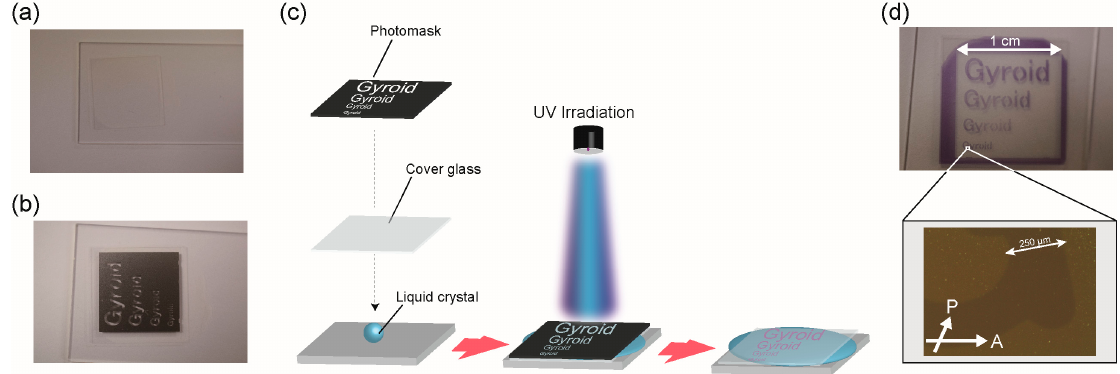
Figure 4. ( a ) Cub bi (V 2+ ) sample sandwiched between a glass plate and a cover glass; ( b ) A picture of the patterned photomask; ( c ) Experimental procedure for UV-pattering experiment; ( d ) A Cub